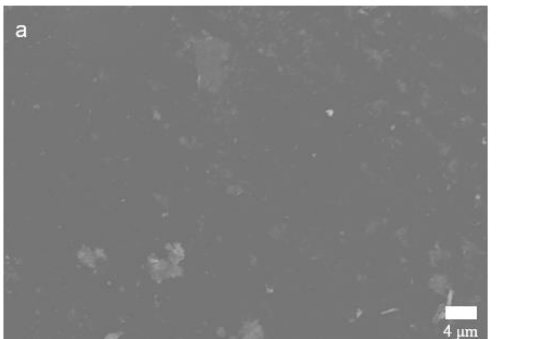
Figure 8. Water permeance and RB rejection profiles of the crosslinked PBI membrane at both neu- tral and pH 13 conditions.